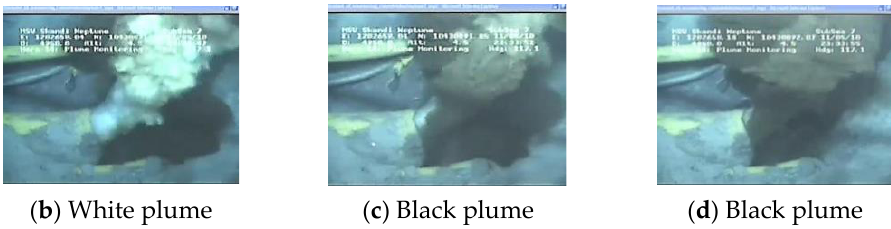
Figure 10. Images of white gas plumes and black oil plumes from BP subsea oil and gas leak accidents. Table 2. The corresponding datasets for developing and testing of monitoring model.